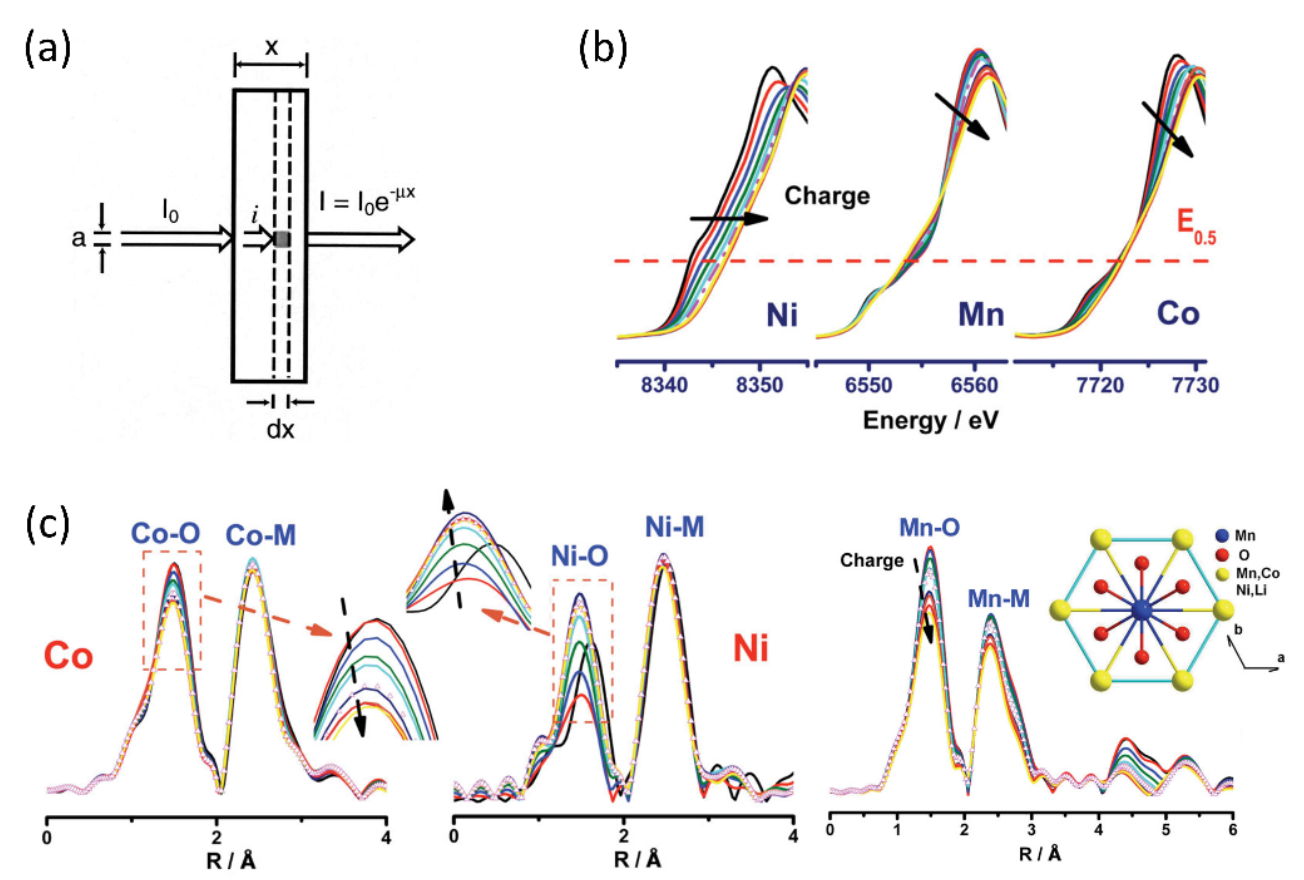
Figure 3. ( a ) The transmission detection mode of hard XAS; ( b ) In-situ XAS spectra of Ni, Co, and Mn during the first cycle charge process of Li 1.2 Ni 0.15 Co 0.1 Mn 0.55 O 2 ; ( c ) The EXAFS results of Ni, Co, and Mn in R space. Reproduced with permission from Refs. [20,42]. Copyright 2000, American Physical Society. Copyright 2014, Wiley-VCH.